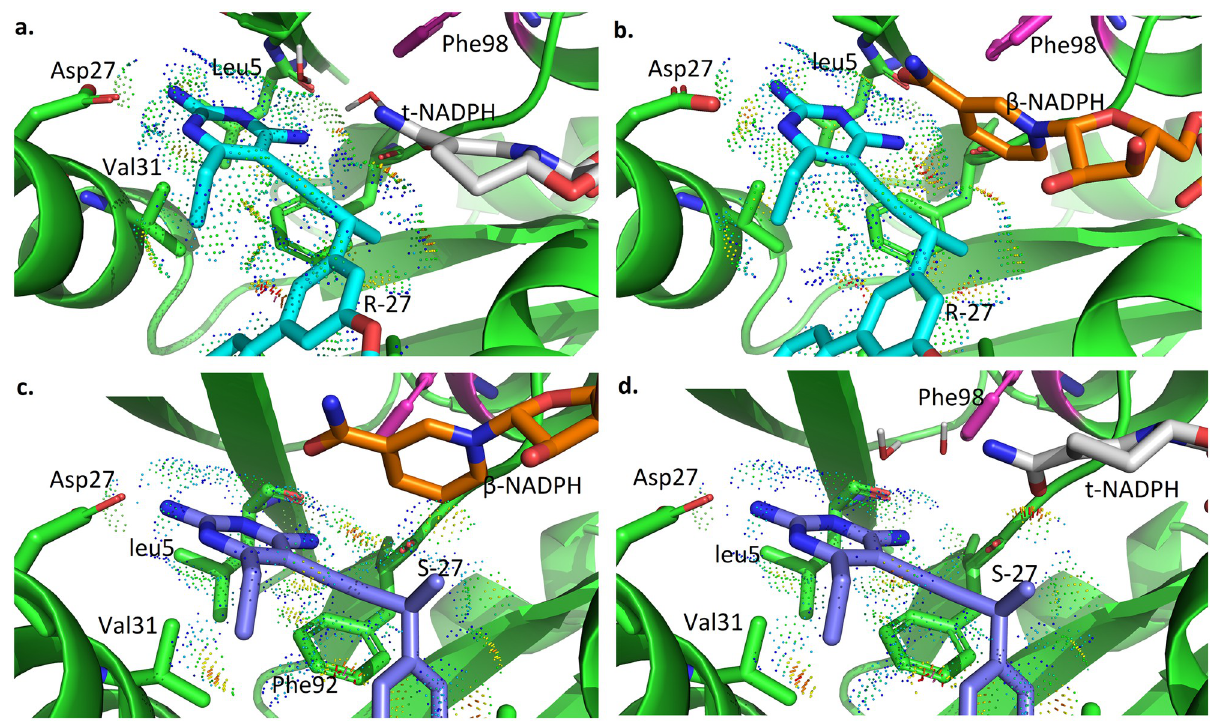
Fig 5. OSPREY -predicted low energy conformations for ternary complexes. a. R27:t-NADPH:DHFR(WT) b. R27: β -NADPH:DHFR(WT) c. S27: β - NADPH:DHFR(WT) d. S27:t-NADPH:DHFR(WT).